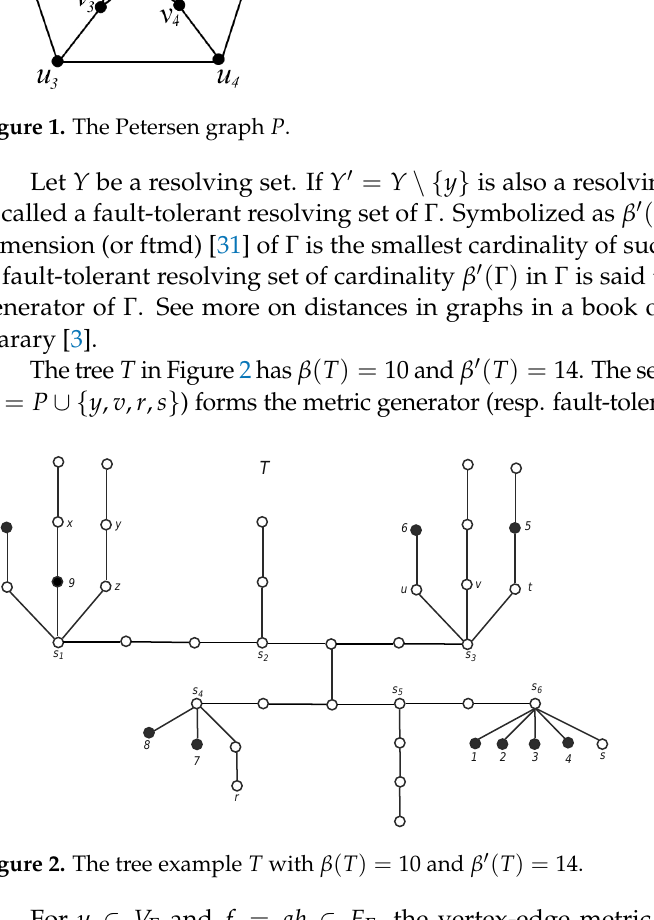
⊆ V Γ if all pairwise k = 1